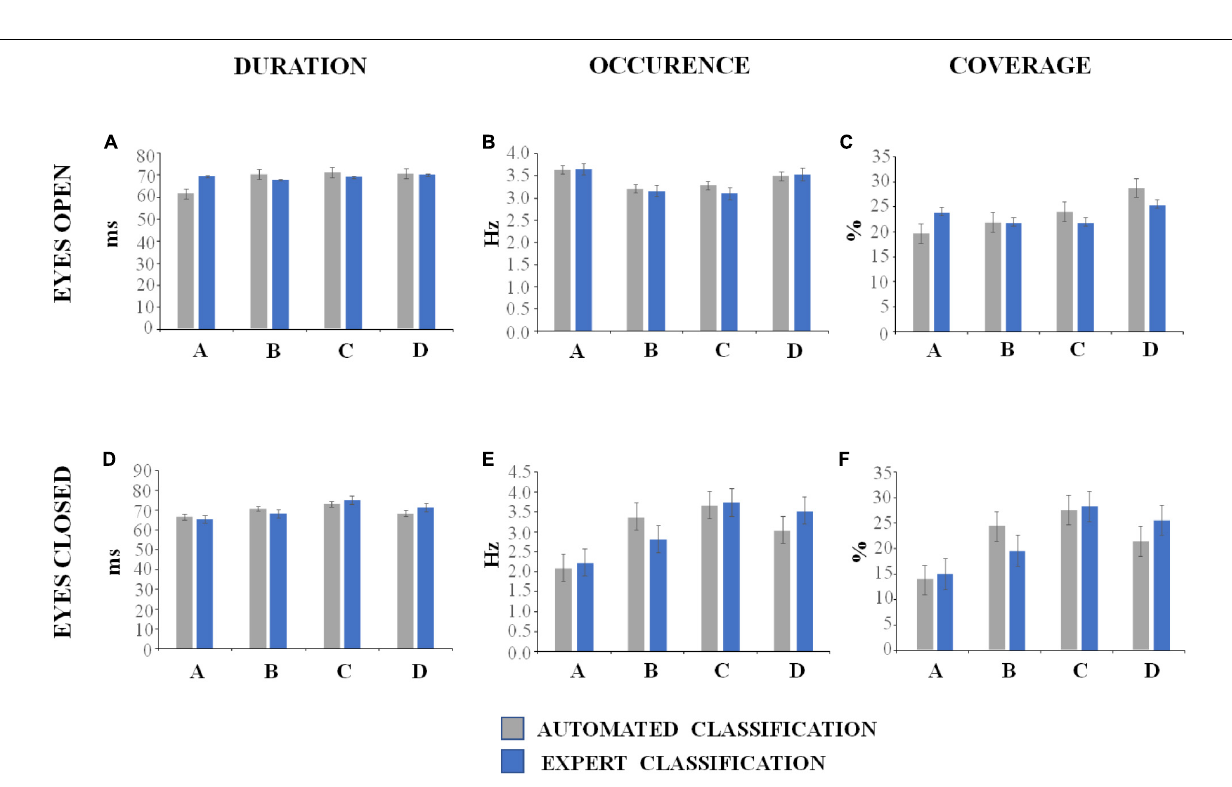
Frontiers in Neuroscience |